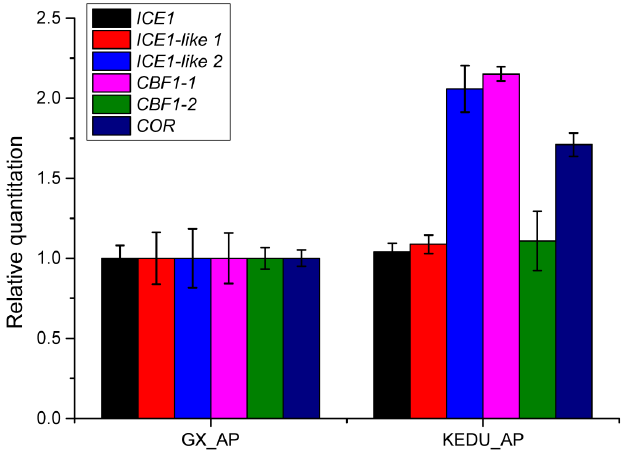
Figure 8. The expression of six genes involved in the ICE1–CBF–COR pathway. ICE , Cluster ‐ 5862.10114; ICE ‐ like 1 , Cluster ‐ 5862.30769; ICE ‐ like 2 , Cluster ‐ 5862.1181; CBF1 ‐ 1 , ICE-like 1 , Cluster-5862.30769; ICE-like 2 , Cluster-5862.1181; CBF1-1 , Cluster-5862.30492; CBF1-2 , Cluster ‐ 5862.30492; CBF1 ‐ 2 , Cluster ‐ 5862.29181; and COR , Cluster ‐ 5862.23126. Cluster-5862.29181; and COR , Cluster-5862.23126.